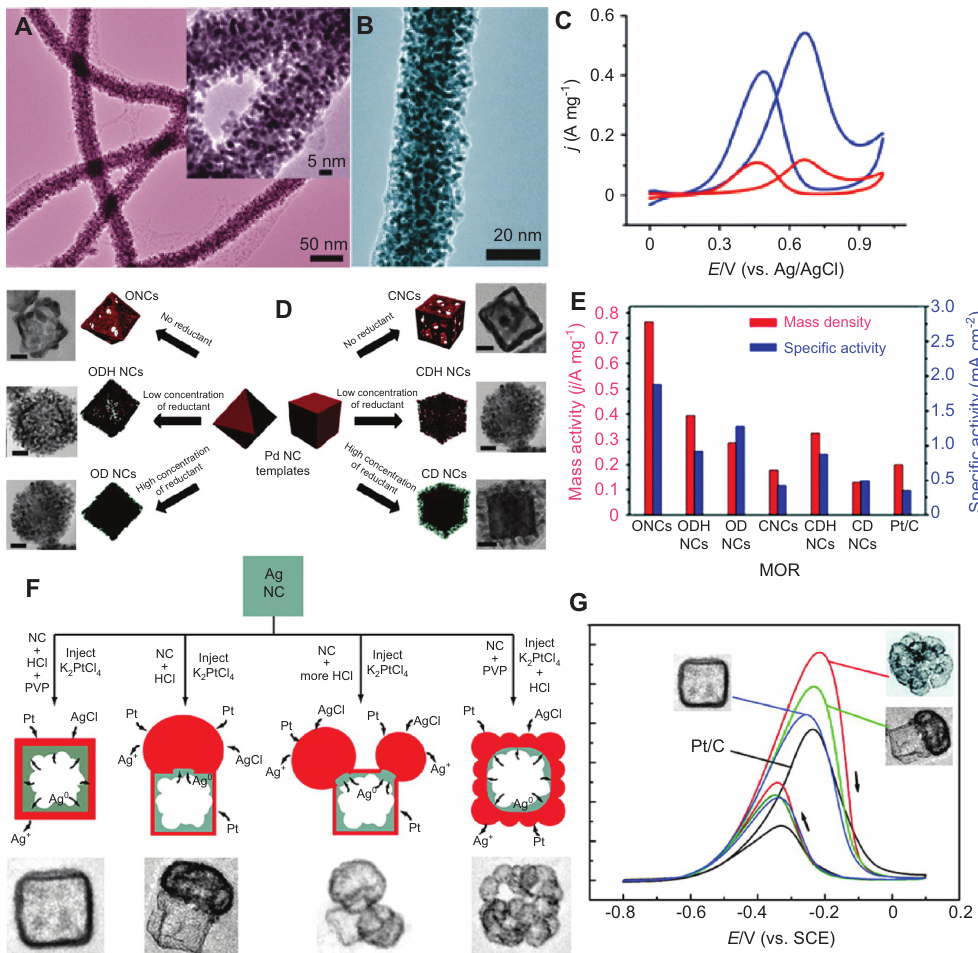
Figure 12 (A–C) Pd-Pt dendritic nanowires and CVs for MOR. Adapted with permission from Ref. [79]. Copyright 2010 The Royal Society of Chemistry. (D, E) Pd-Pt dendritic nanocrystals and mass- and area-specific activities for ORR. Adapted with permission from Ref.